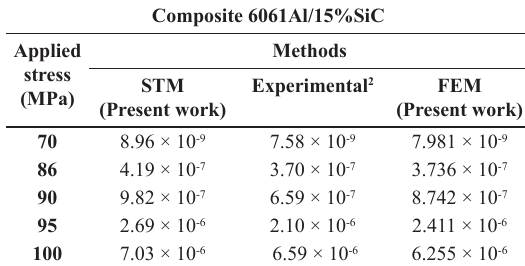
Figure 5. The average obtained results for achieving total strain rate behavior in r-direction at r = b, 0 < z < l in the creeping matrix with assumption of